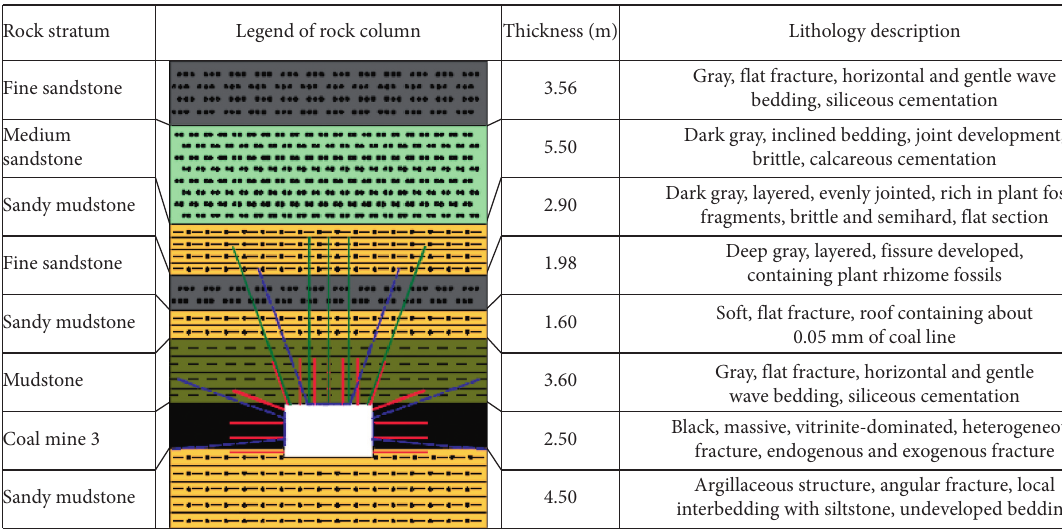
Figure 2: Coal and rock strata